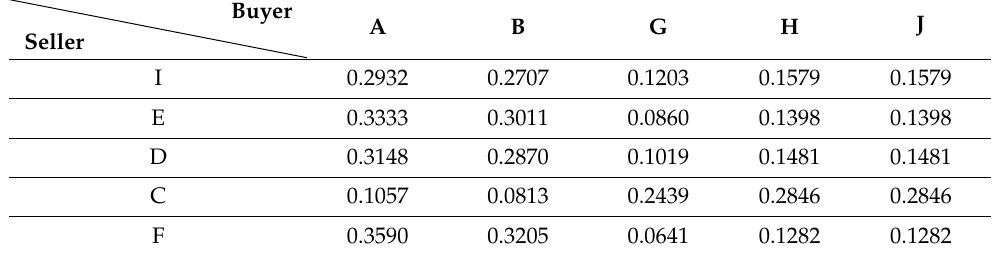
Table 4. The distance factor.